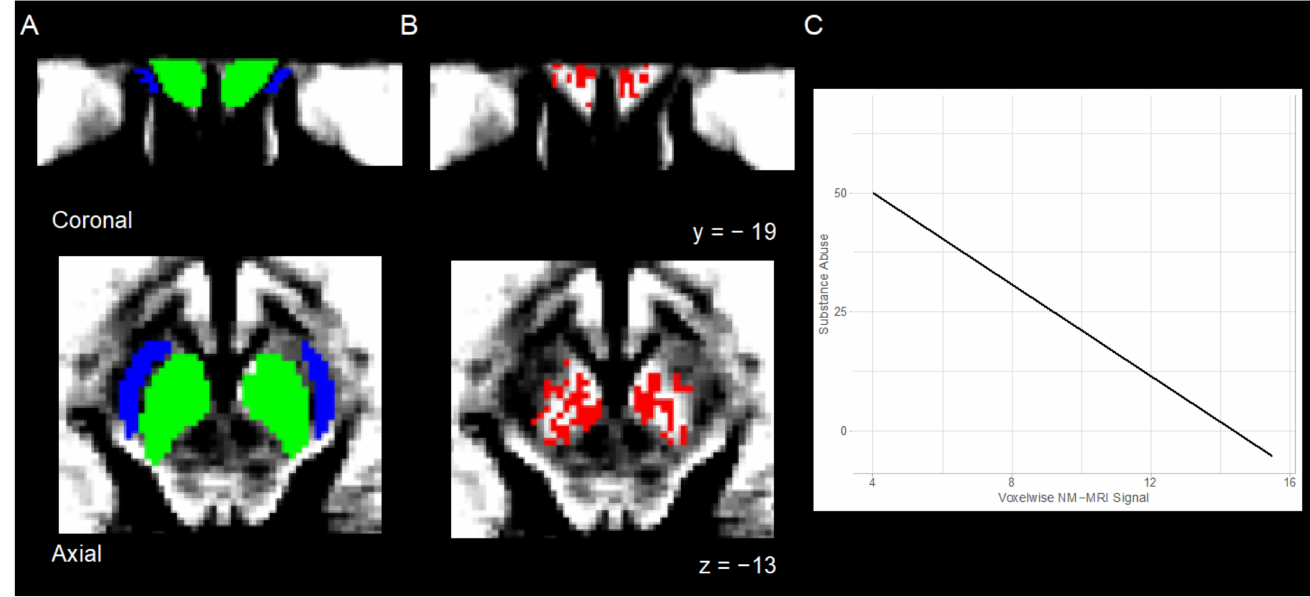
Figure 2. Template NM-MRI images were created by averaging the spatially normalized NM-MRI images from all participants. Overlays reflect ( A ) anatomical substantia nigra (green) and crus cerebri (blue) masks; ( B ) results from voxelwise analysis showing a significant negative relation between substance abuse and NM-MRI signal in substantia nigra (red). ( C ) Scatter plot depicting this negative